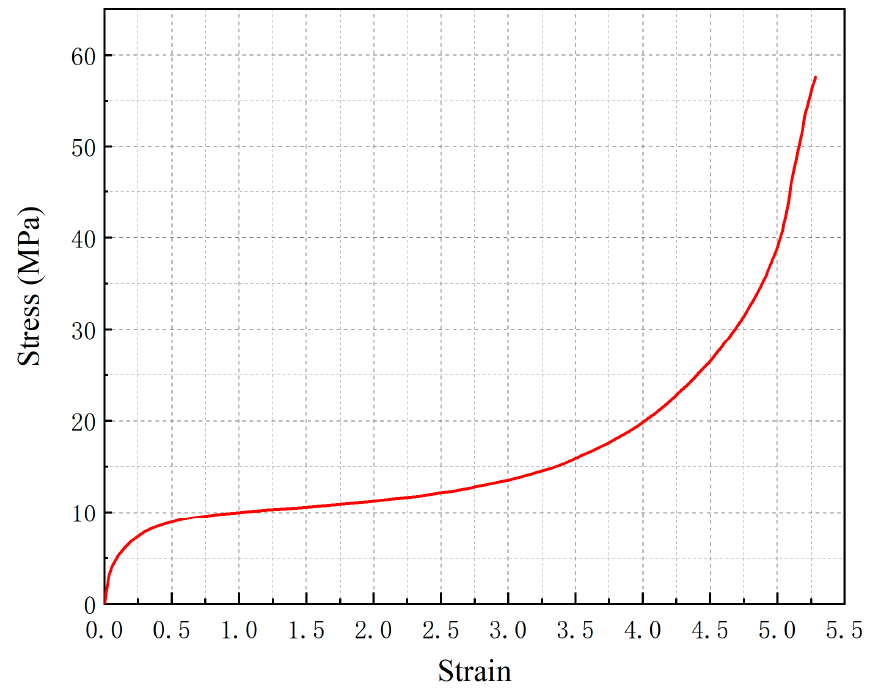
Figure 9. Stress–strain curves of spoke material.